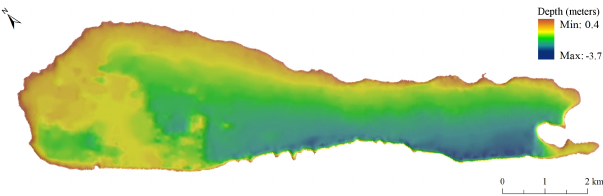
Figure 13. Bathymetric map of Lake Vrana (ordinary